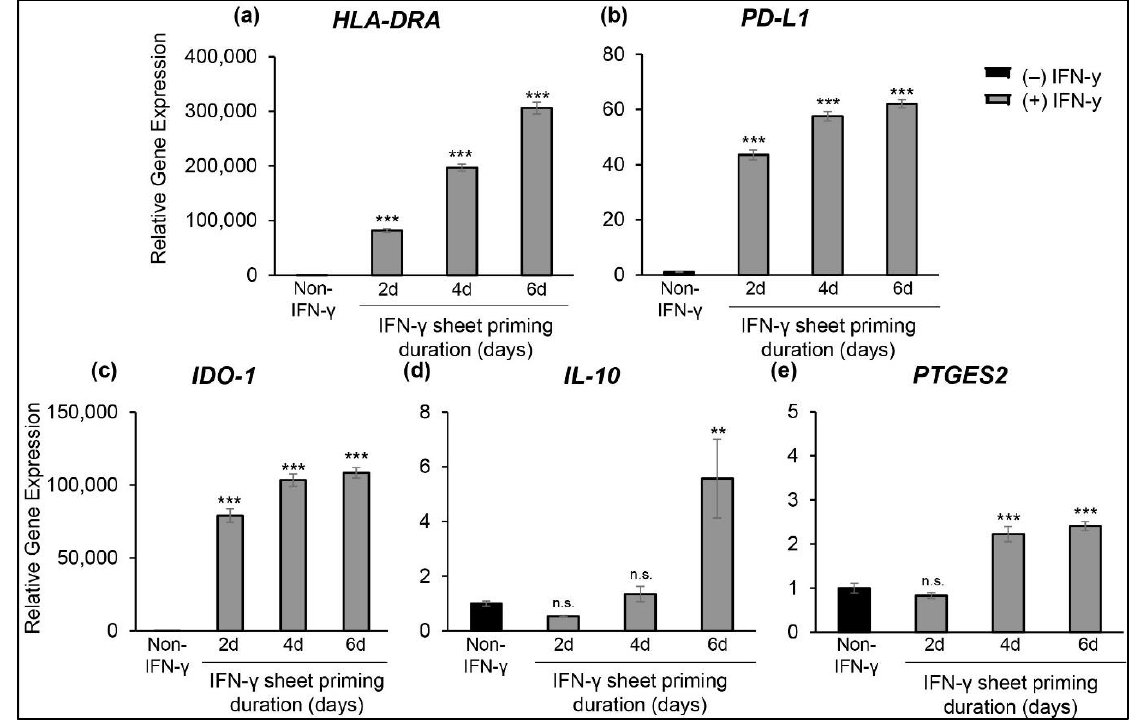
Figure 2. Duration of IFN- γ priming is directly related to enhanced hcBMSC sheet gene expression of immunomodulatory factors. Quantitative real-time PCR gene expression for immunomodulatory genes ( a ) human leukocyte antigen DR (HLA-DRA), ( b ) programmed death ligand-1 (PD-L1), ( c ) indoleamine 2,3-dioxygenase (IDO-1), ( d ) interleukin 10 (IL-10), and ( e ) prostaglandin E synthase 2 (PTGES2). All gene expression is normalized to GAPDH, fold change is relative to non-primed control hBMSC sheet sample. Error bars represent means ± SE ( n = 6) (n.s. p ≥ 0.05, ** p < 0.01, *** p < 0.001) Statistical analysis p values are compared to non-IFN- γ hcBMSC sheets ( non-IFN- γ, control).